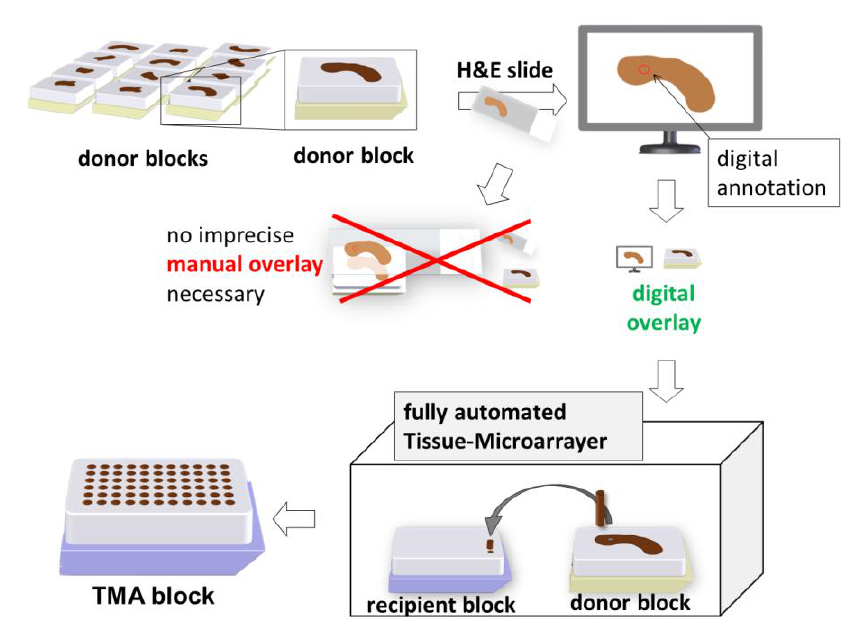
Figure 1. Workflow of automated TMA Production. One donor block is selected, and an H&E slide is made and digitalised. In this digital image, an annotation is marked. The Tissue-Microarrayer now takes a picture of the donor block, and a digital overlay with the annotated H&E slide is made by the operator. Now the annotated region is punched and transferred into the recipient TMA block. 3D sketches with kind permission of W. Müller